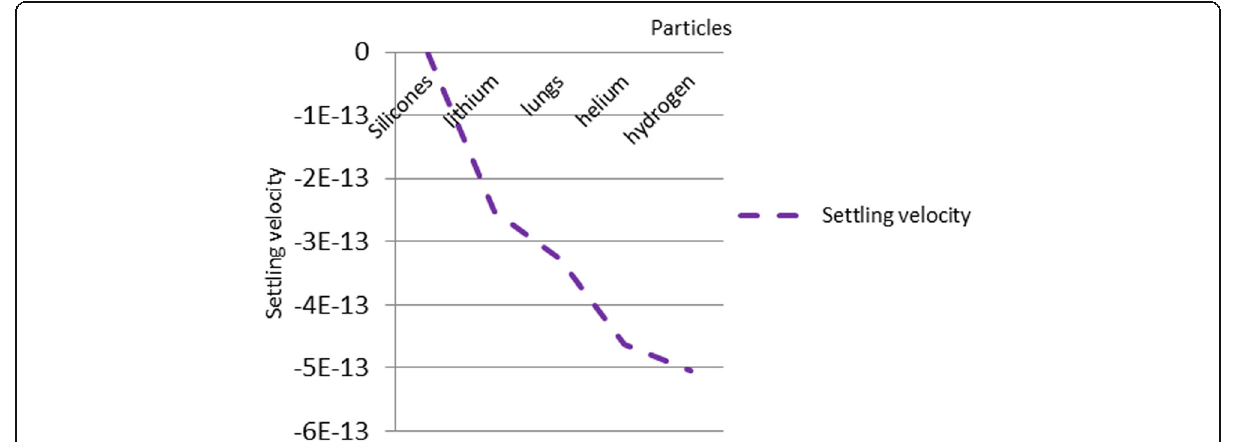
Fig. 5 The settling velocity data for each particle